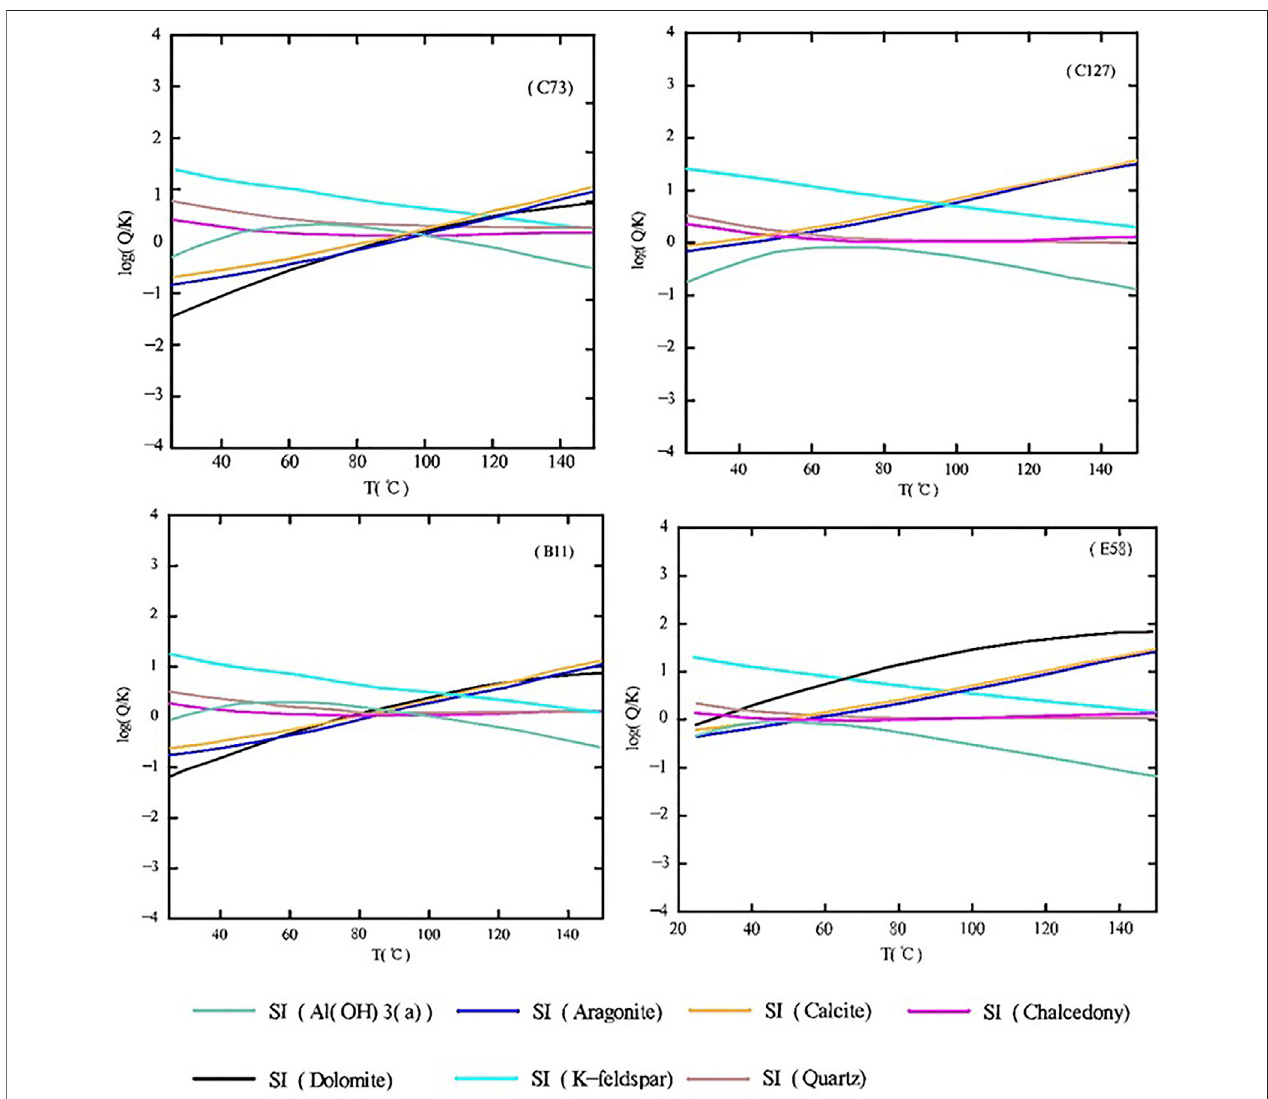
FIGURE 8 | SI-T curves of various minerals in the warm spring water in the Jiangcang Basin.